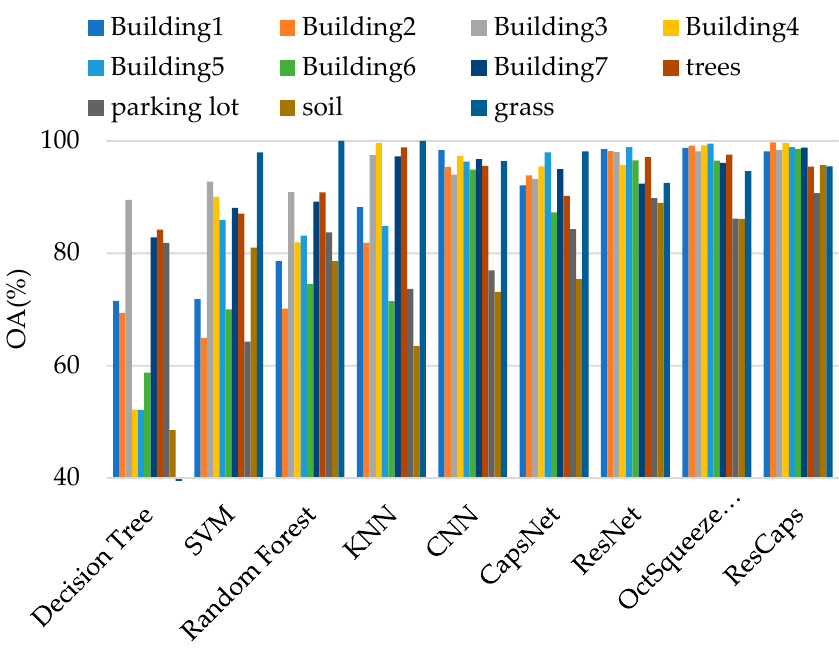
Figure 9. Classification results of different methods for each class on Recology data set.